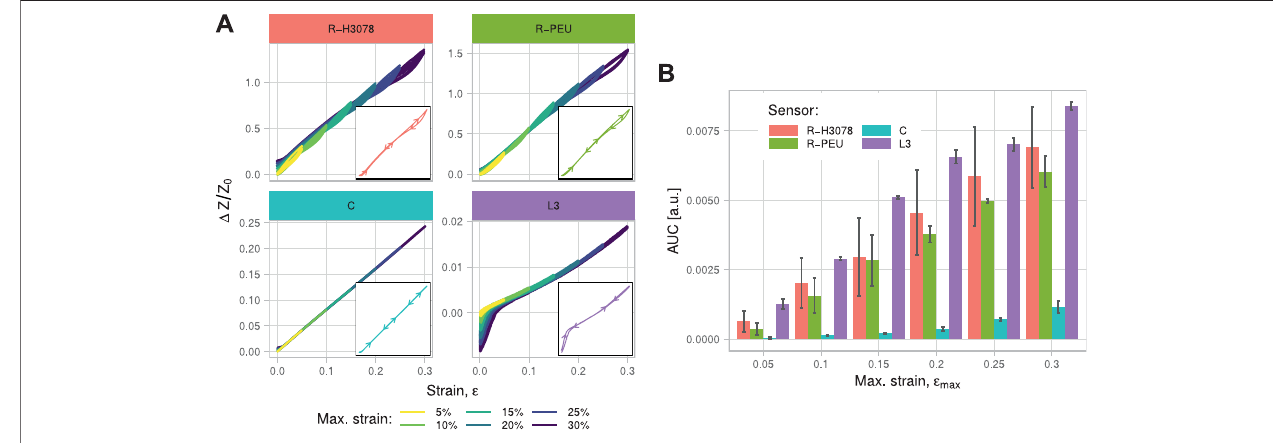
FIGURE 5 | Results of the hysteresis test. (A) The overlaid sensor responses to a triangular strain pattern with the directionality of the hysteresis loop at 30% strain shown (inset). (B) Hysteretic loss by sensor type and maximum strain level. Error bars indicate the standard deviation of 3 sequential trials.